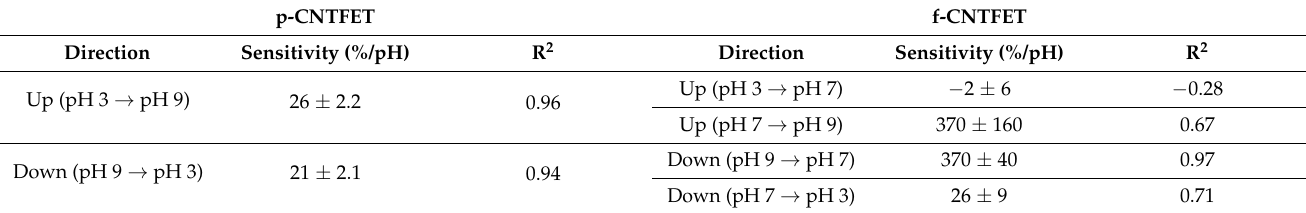
Table 3. Calculated relative sensitivity of p-CNTFET and f-CNTFET from pH 3 to pH 9. The sensitivity of f-CNTFET is calculated in two di ff erent ranges, from pH 3 to pH 7 and from pH 7 to pH 9.